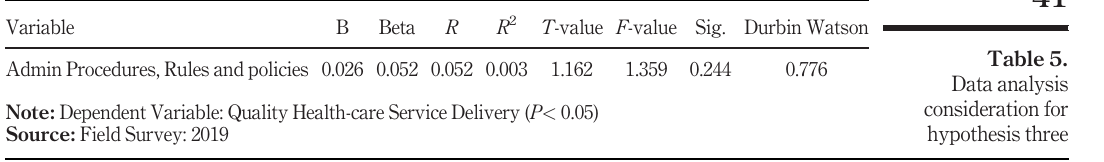
Table 5. Data analysis consideration